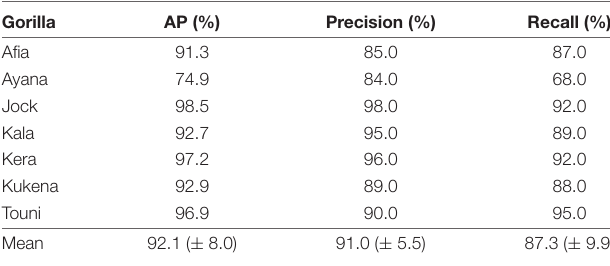
TABLE 3 | Single frame YOLOv3 identification performance.